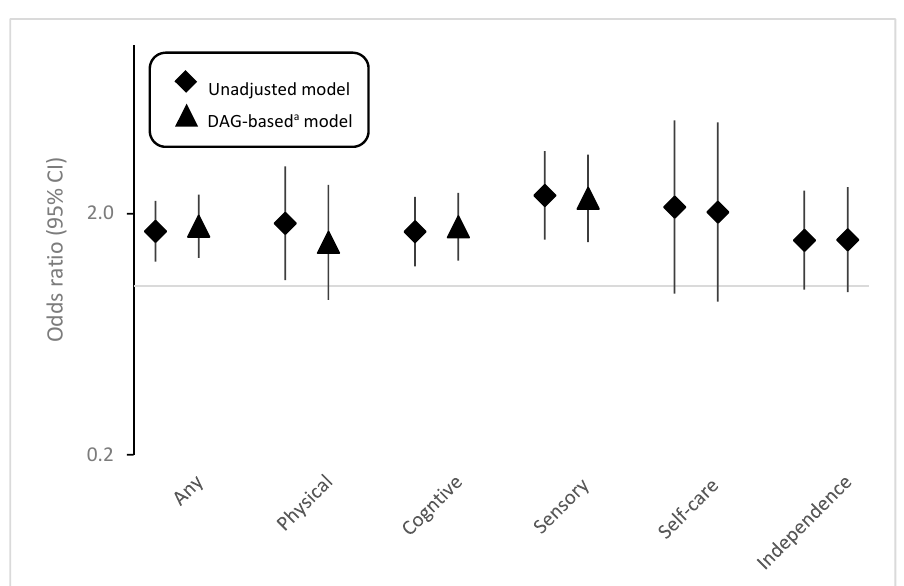
positive but not statistically significant (Figure 1, Table S3).